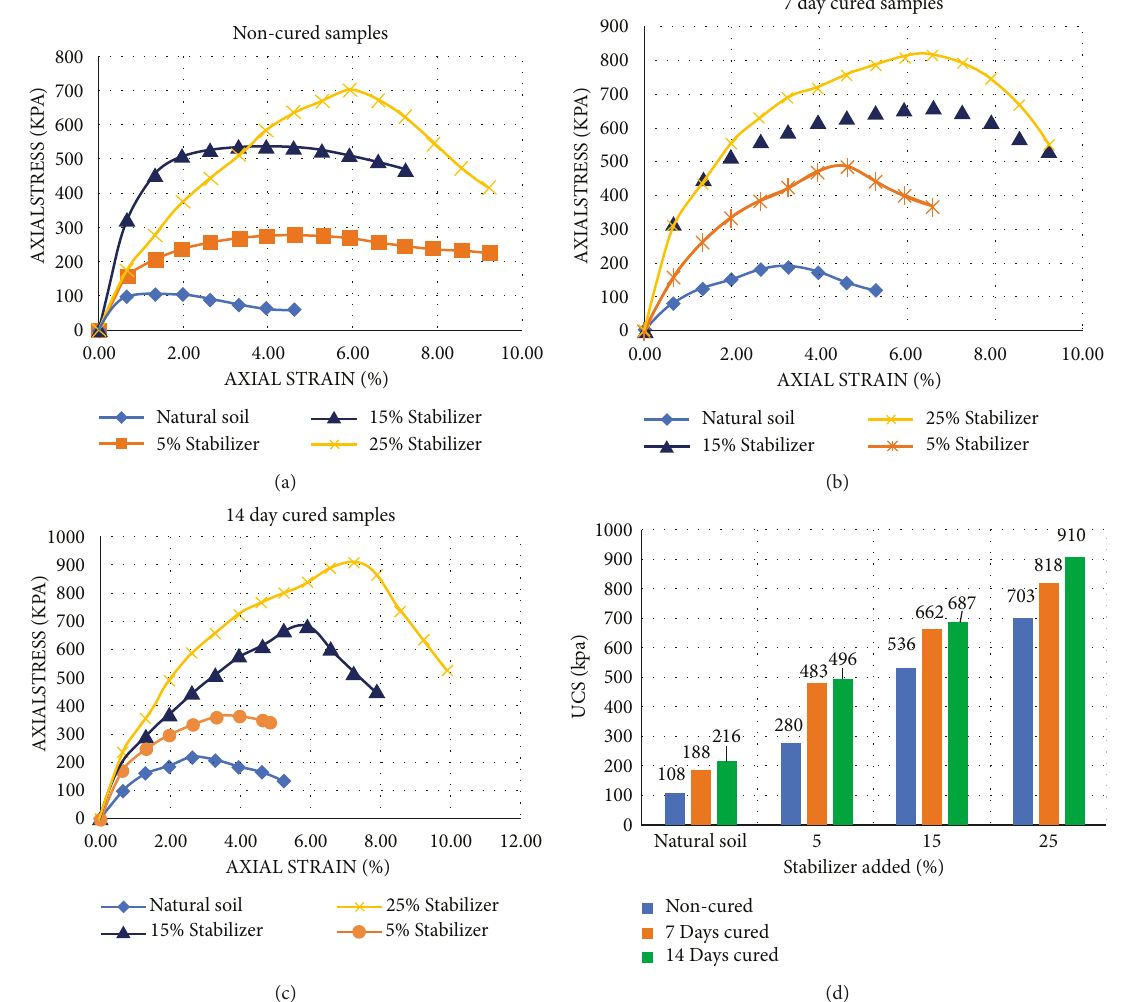
Figure 8: Effects of the stabilizer on UCS for cured and noncured